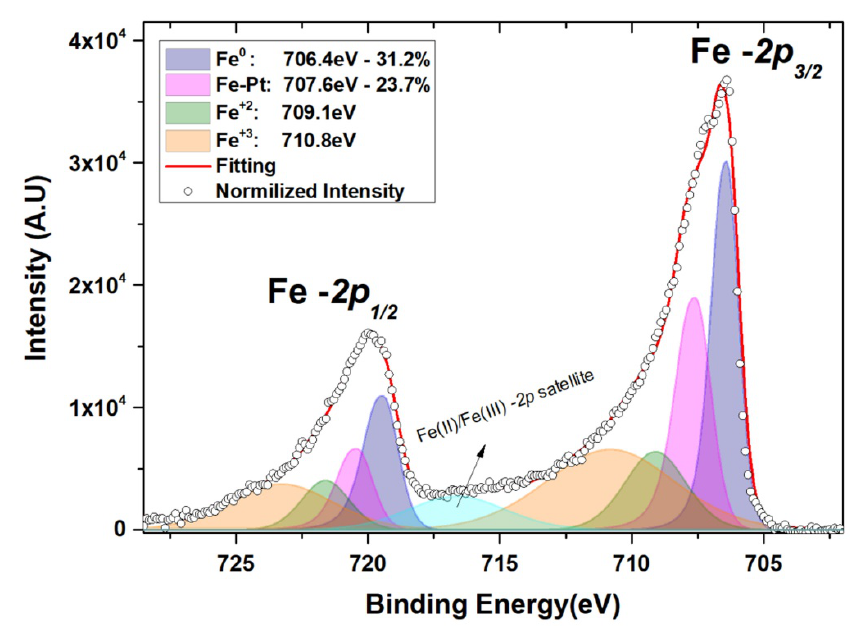
Figure 3. HR peaks of Fe - 2p orbitals at 12 nm of depth. The deconvolution reveals a four-contribution peak for each of the 2p 3/2 and 2p 1/2 photoelectron signals, providing the oxidation states of Fe, along with the bimetallic interactions from a relatively significant rough interface.